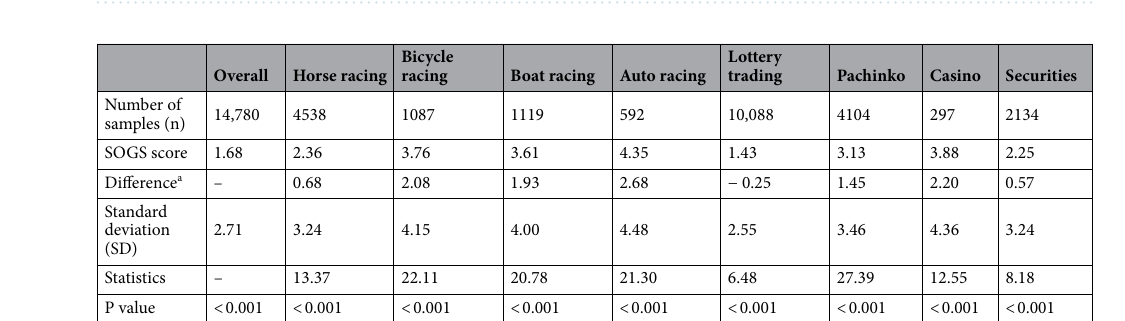
Figure 1. SOGS score distribution (N = 14,780) 17 .